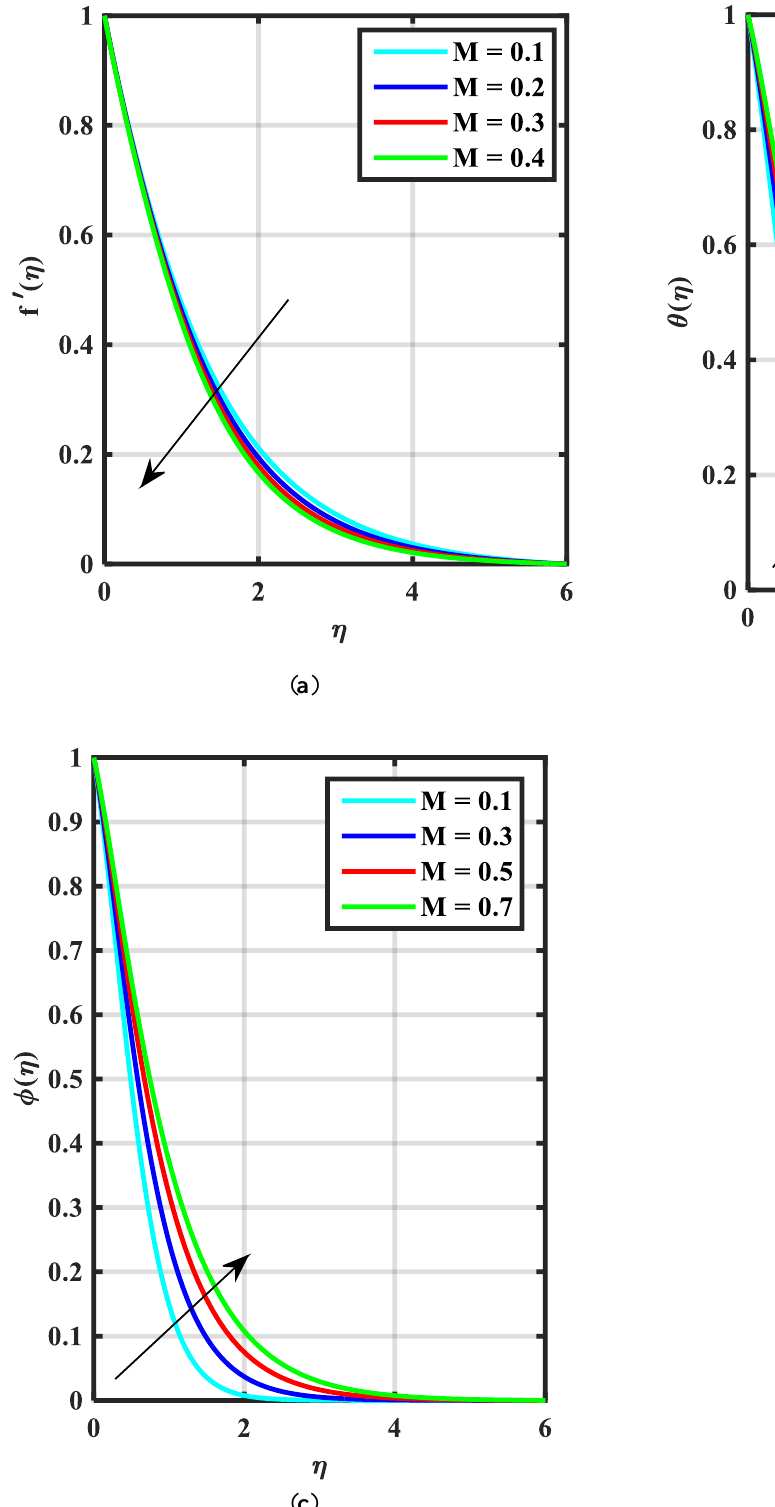
Figure 4. ( a – c ) Influence of 𝑓 ′ ( 𝜂 ) , 𝜃 ( 𝜂 ) 𝜙 ( 𝜂 ) over magnetic parameter 𝑀 . Figure 4. ( a–c ) Influence of f (cid:48) ( η ) , θ ( η ) φ ( η ) over magnetic parameter M